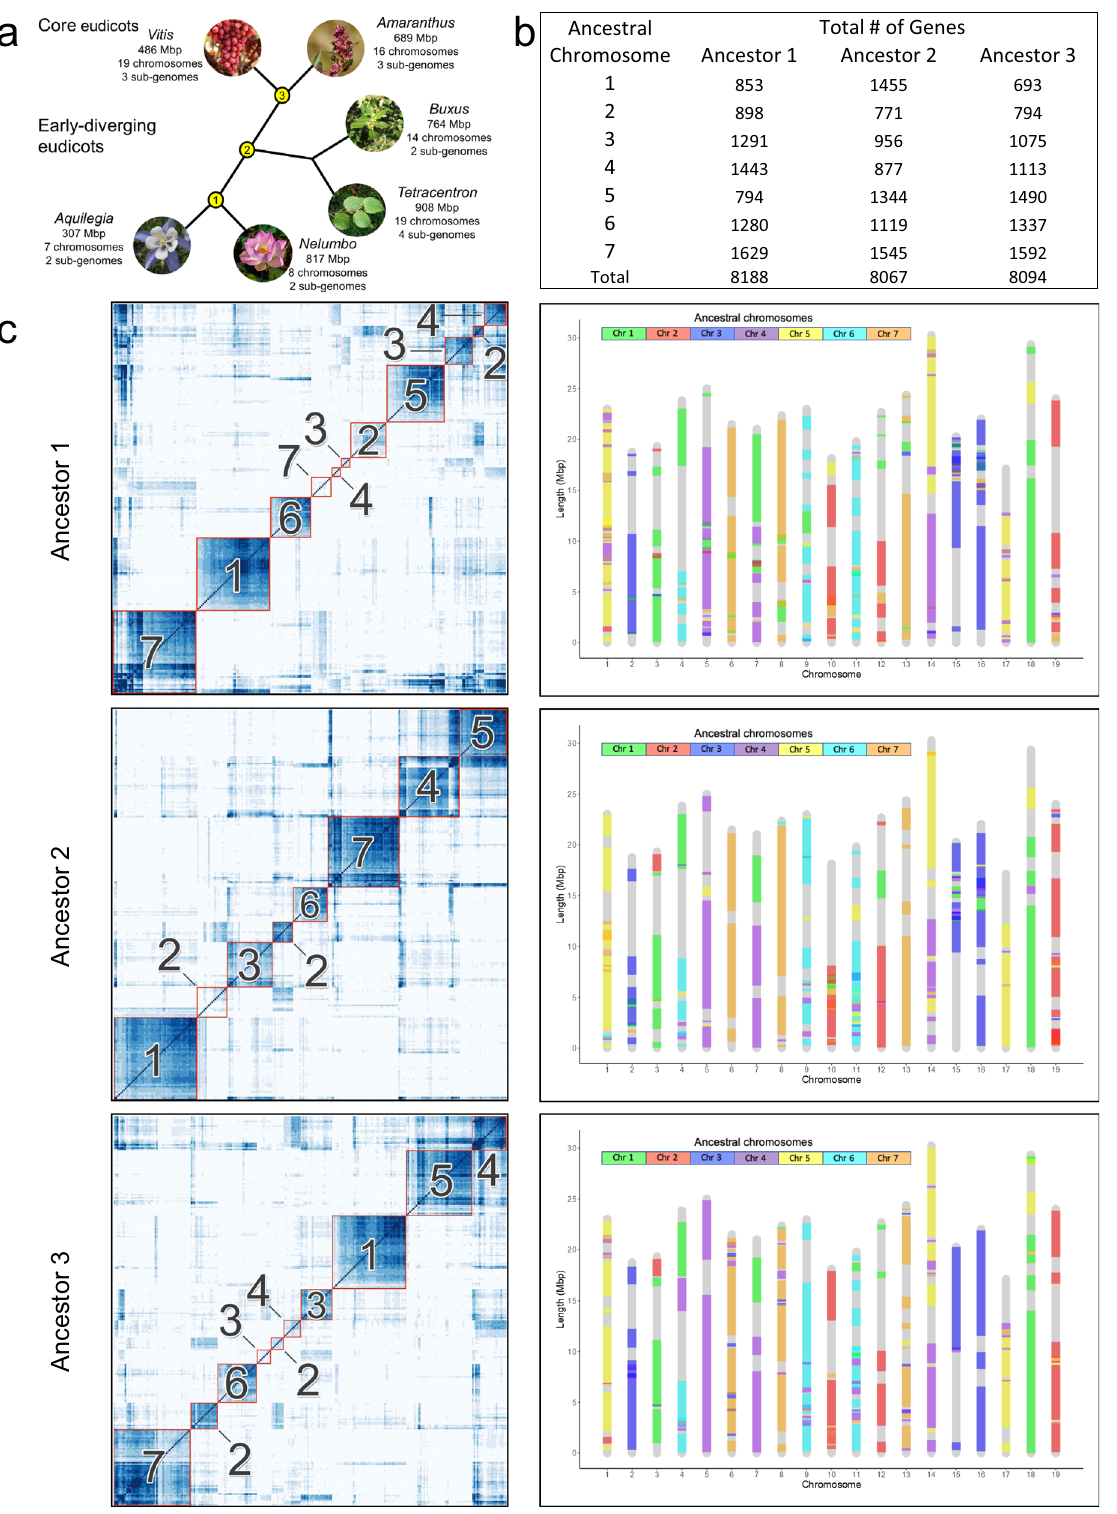
Fig. 4 Ancestral eudicot genomes. a Schematic phylogeny of the eudicot clade depicting extant and ancestral genomes (nodes 1 – 3) examined here. Images Credits: Vitis , Bob Nichols; Amaranthus , Patrick Alexander; Buxus , PiPi; Tetracentron , Daderot; Nelumbo , Engin Akyurt; Aquilegia , Ejohnsonboulder;